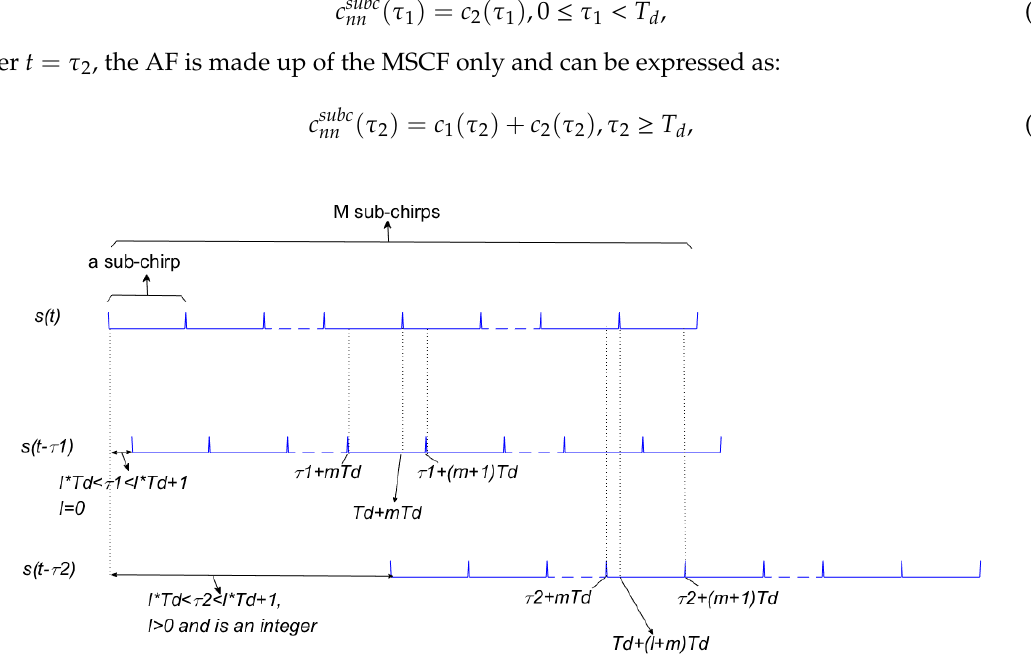
Figure 3. Autocorrelation function a structure diagram.